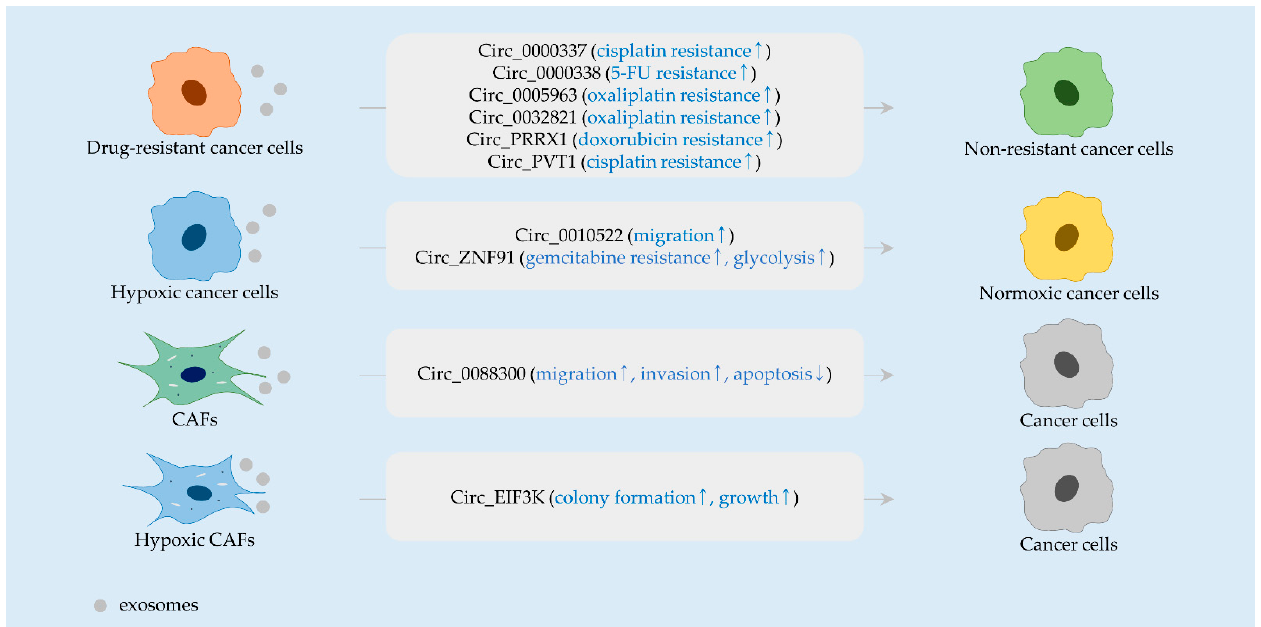
Figure 1. Exosomal circRNAs secreted from drug-resistant cancer cells, hypoxic cancer cells, CAFs, and hypoxic CAFs. CircRNAs (black), and their biological functions (blue) are indicated in rounded rectangles. Arrows indicate the upregulation ( ↑ ) and downregulation ( ↓ ).